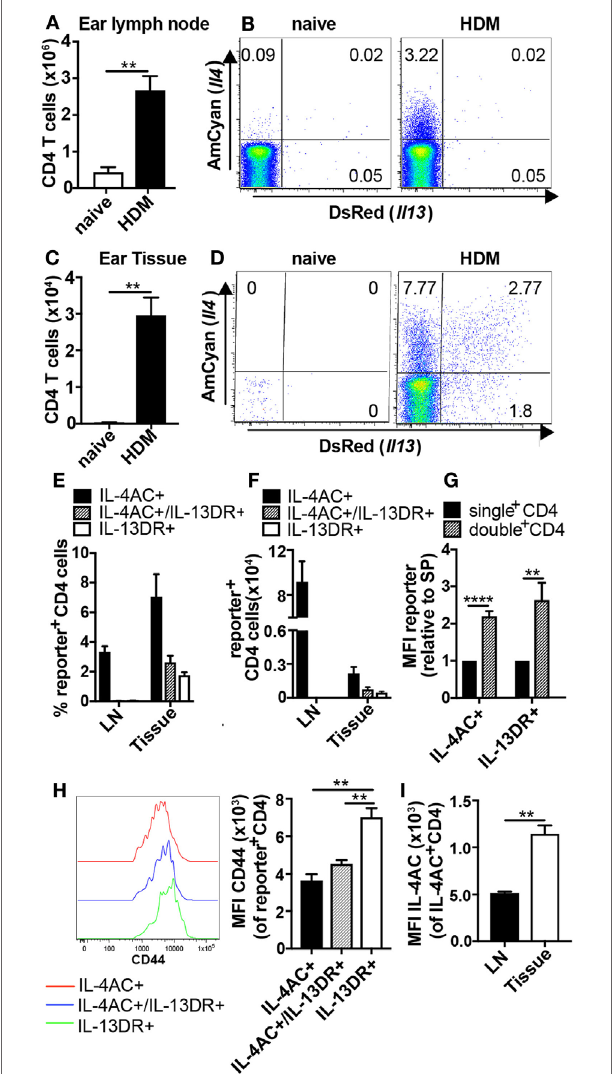
FigUre 1 | Priming with house dust mite (HDM) allergen induces the development of Th2 subsets producing only IL-4AC in the lymph node and distinct IL-4AC, IL-4AC/IL-13DR, or IL-13DR expression profiles in the ear tissue. 4C13R transgenic mice were challenged with 200 μ g HDM i.d. in the ear. Ear draining lymph nodes and ear tissue were harvested 7 days later, and the presence of IL-4AC- and IL-13DR-expressing CD4 Th2 cells examined by flow cytometry. (a,c) Number of CD4 T cells in ear lymph node and ear tissue. (B,D) Concatenated FACS plots of CD4 T cells from naïve and HDM primed 4C13R transgenic mice showing IL-4AC + and IL-13DR + cells. (e) Proportions and (F) numbers of IL-4AC + , IL-4AC + /IL-13DR + , and IL-13DR + subsets in the ear lymph node and ear tissue. (g) Median fluorescent intensity (MFI) of IL-4AC and IL-13DR reporters expressed in single reporter + vs double reporter + CD4 Th2 cells in the ear tissue (relative to MFI of single-positive cells). (h) MFI of CD44 expression on IL-4AC + , IL-4AC + /IL-13DR + , and IL-13DR + CD4 + Th2 cells in the ear tissue. 96–98% of the reporter positive Th2 cells were CD44 + (i) MFI of IL-4AC expression in IL-4AC + CD4 cells from ear lymph node and ear tissue. (a–g,i) Data from an experiment ( n = 3–5) representative of nine lymph node experiments and seven ear tissue experiments. (h) Results from a single experiment ( n = 3), representative of three experiments. Data show mean + SEM (** p ≤ 0.01 and **** p ≤ 0.0001 two-tailed t